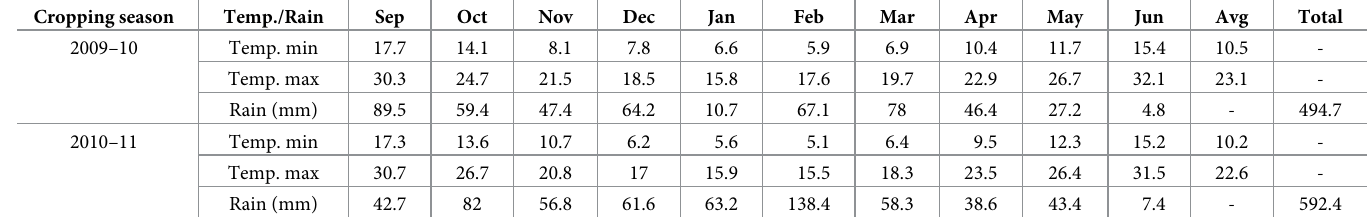
Table 2. Climatic data (monthly minimum, maximum and average temperature (˚C) and rain (mm) recorded in Beja research station during the two cropping sea- sons 2009/2010 and 2010/2011. Cropping season Temp./Rain Temp.